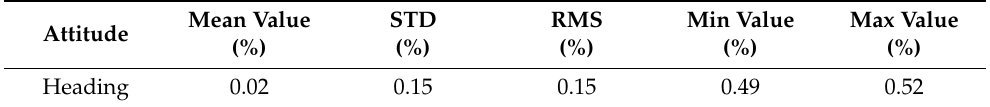
Table 7. Difference between the measured and reference heading angle expressed in relative percent- age terms in dynamic